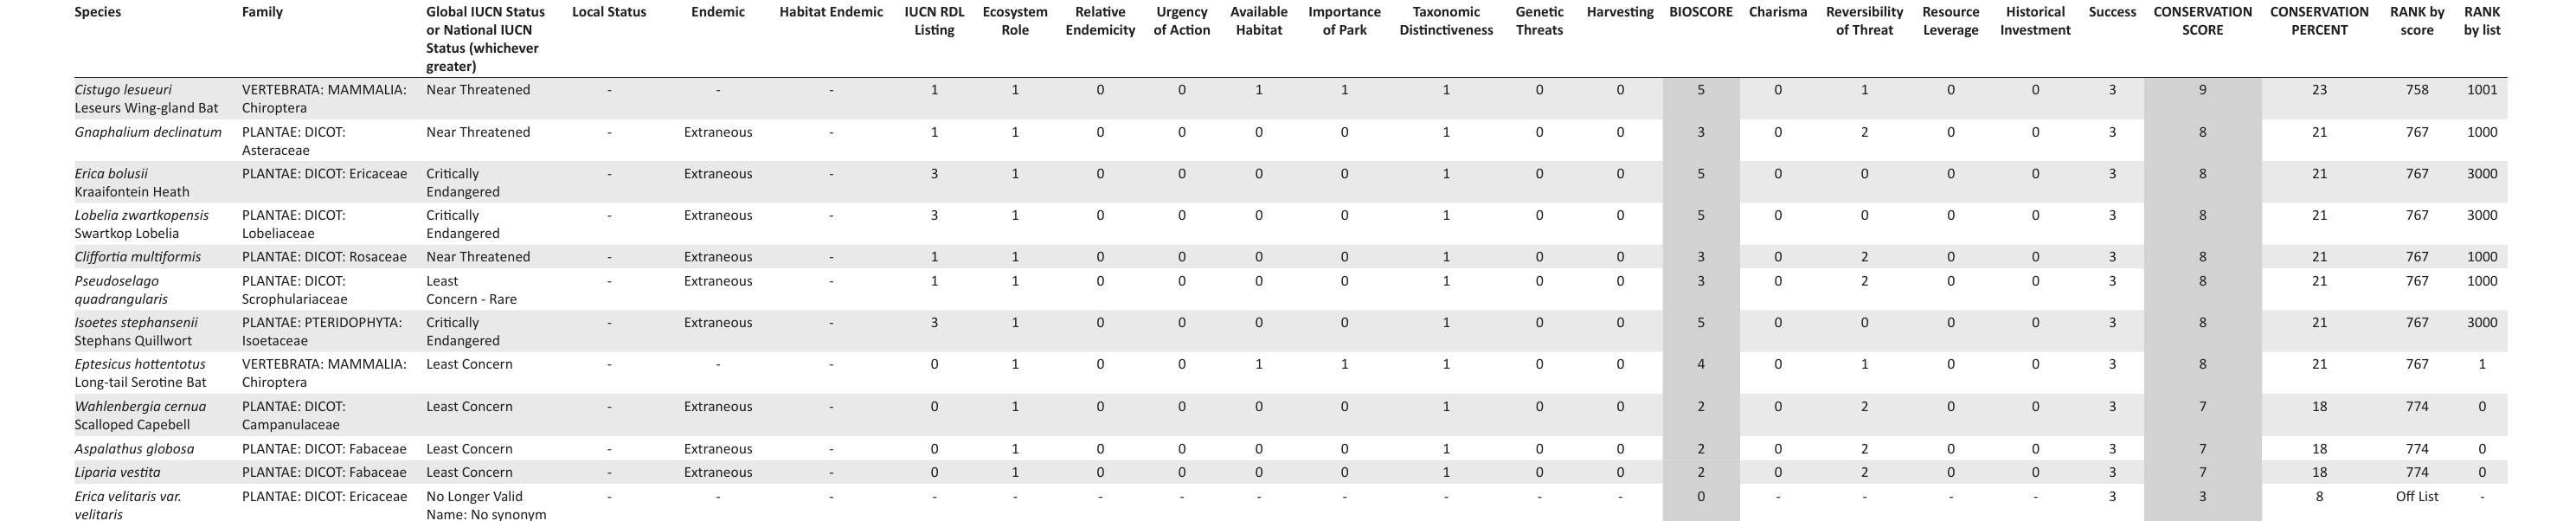
Online Appendix Table 1 (Continues...): List of species of Special Concern in the Table Mountain National Park and associated scores Species